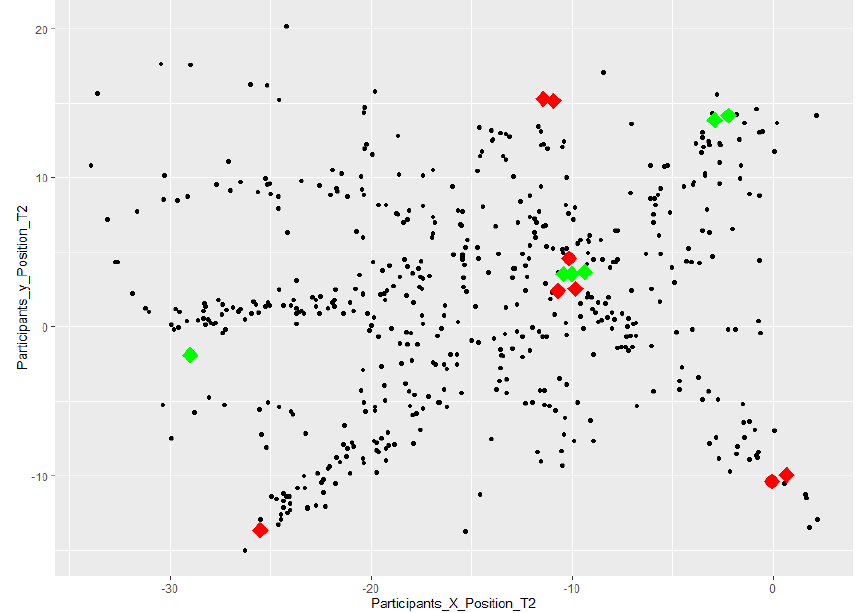
Figure 13. A visualization of participants’ change of position in Task 2; the task targets related to before the change of the task are shown in red; the task targets related to after the change of the task are shown in